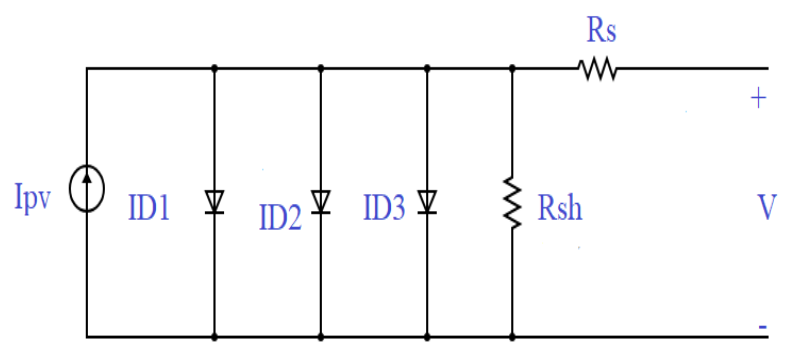
Figure 3. TDMSC circuit.